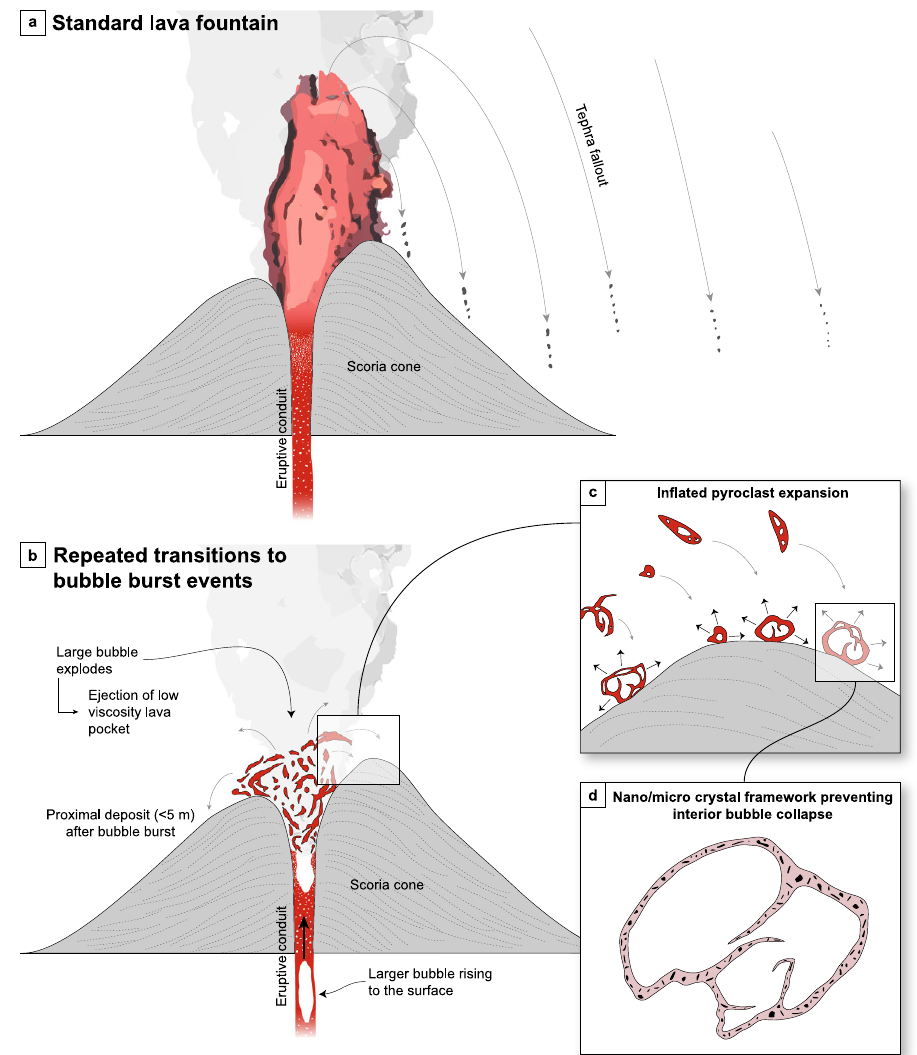
Fig. 9 Summary cartoon of the eruptive processes that operated at the Satellite cone, Tseax volcano. The diagrams are schematically drawn and are not to scale. a Standard lava fountain producing regular scoria. b Repeated transitions to a low-energy bubble burst ejecting low viscosity lava fragments